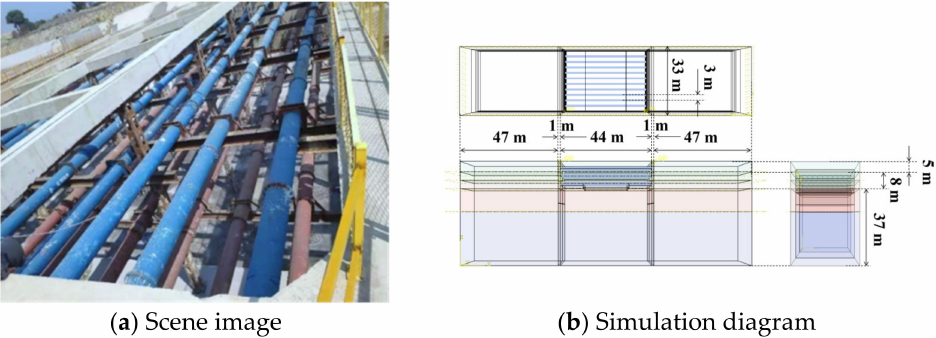
Figure 1. The structure of the foundation pit.